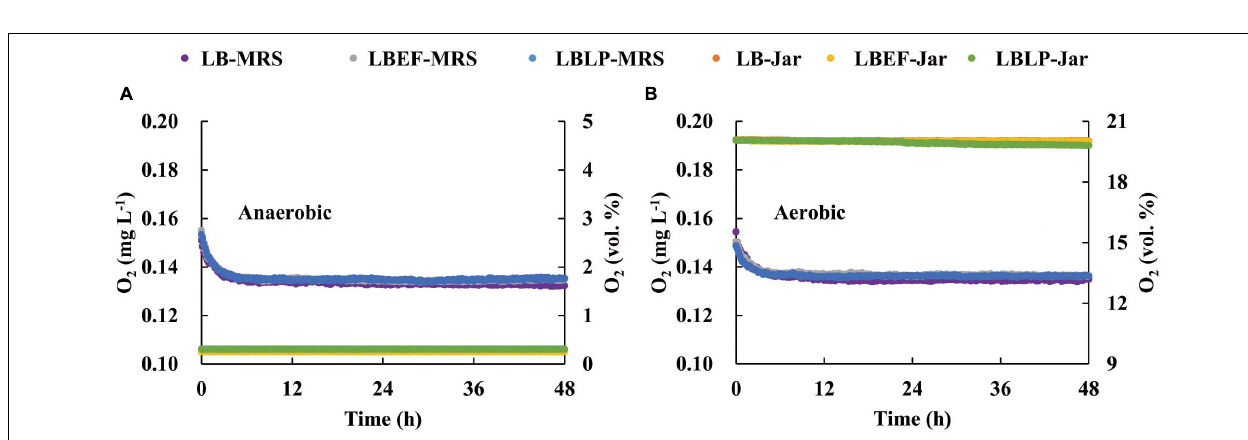
FIGURE 4 | Time courses of O 2 concentration dissolved in the De Man, Rogosa, and Sharpe (MRS) and distributed in the sealed jars during the anaerobic (A) and aerobic (B) fermentations. MRS, De Man, Rogosa, and Sharpe.